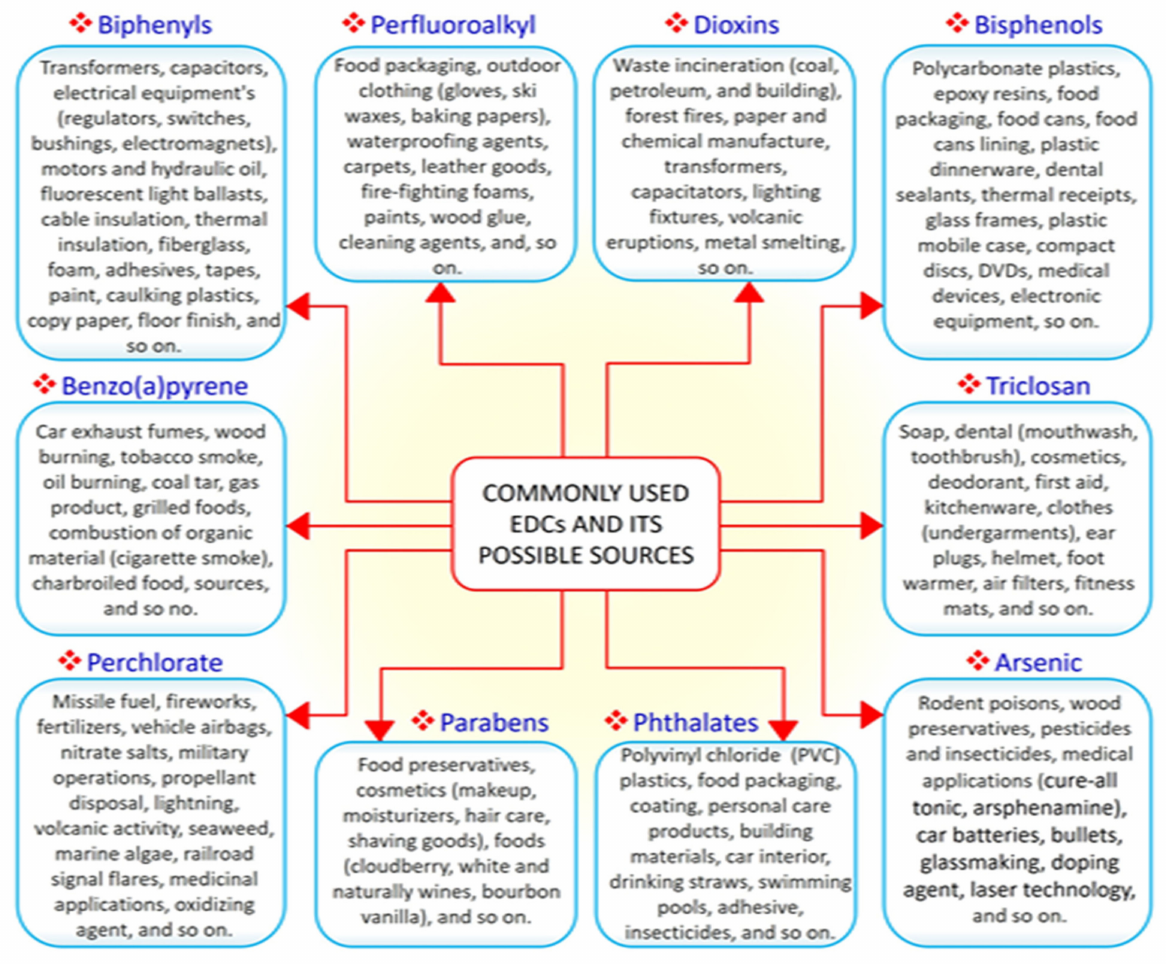
Figure 1. The 10 commonly used endocrine-disrupting chemicals (EDCs) and their common